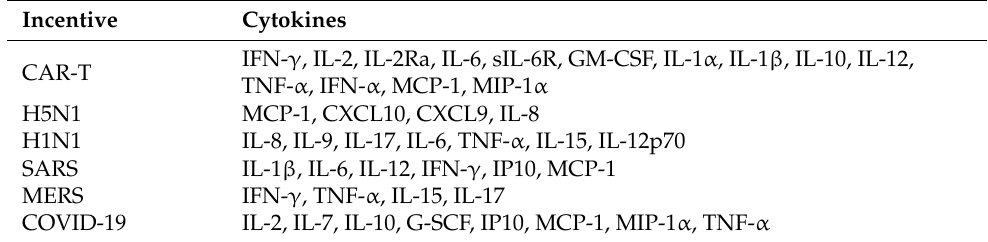
Table 1. The incentive and related cytokines of